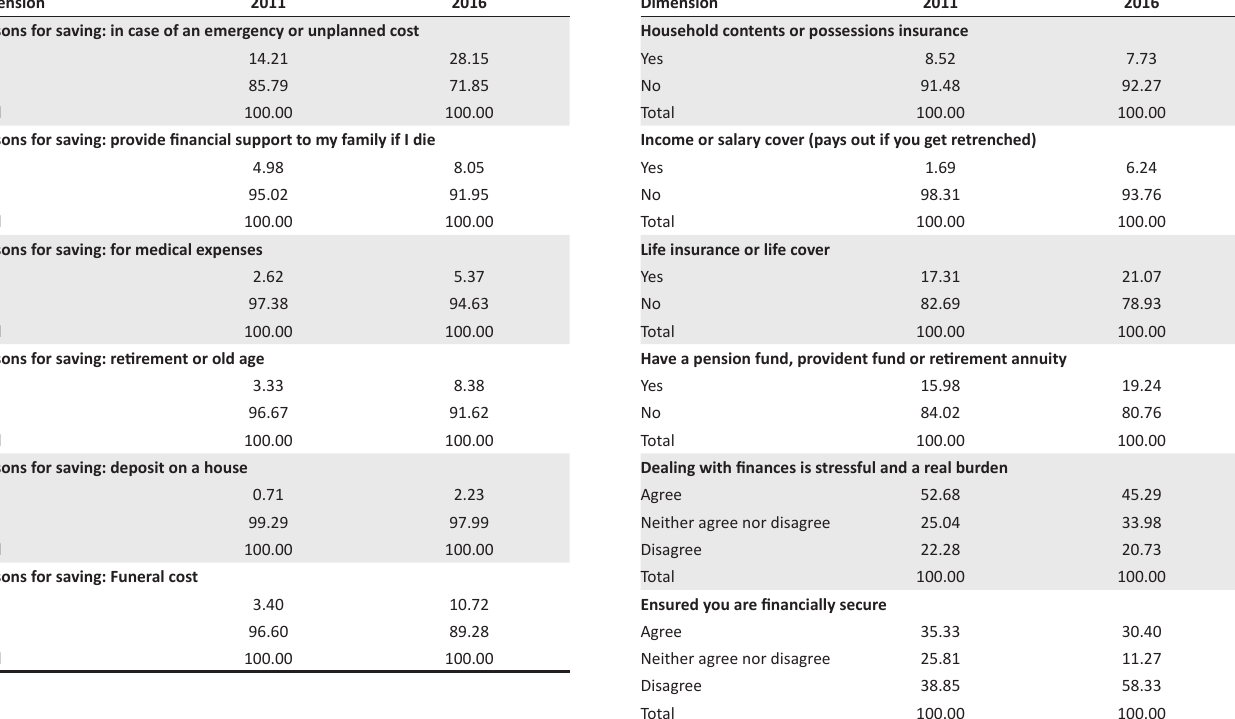
TABLE 7-A1: Description of data on the saving dimension of financial health ( % ). Dimension